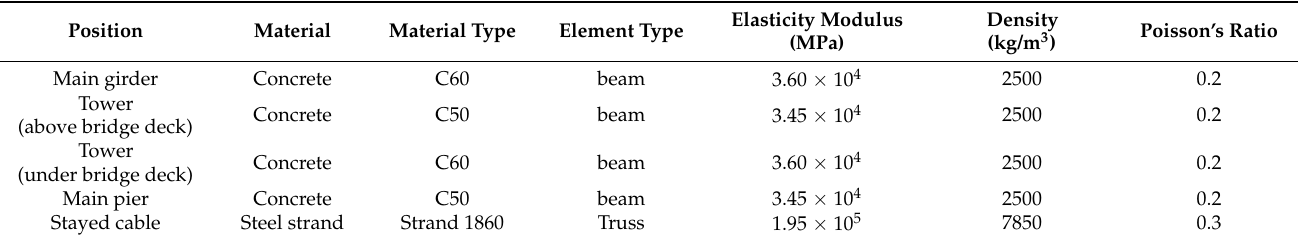
Table 2. Boundary conditions in the FE model of the structural